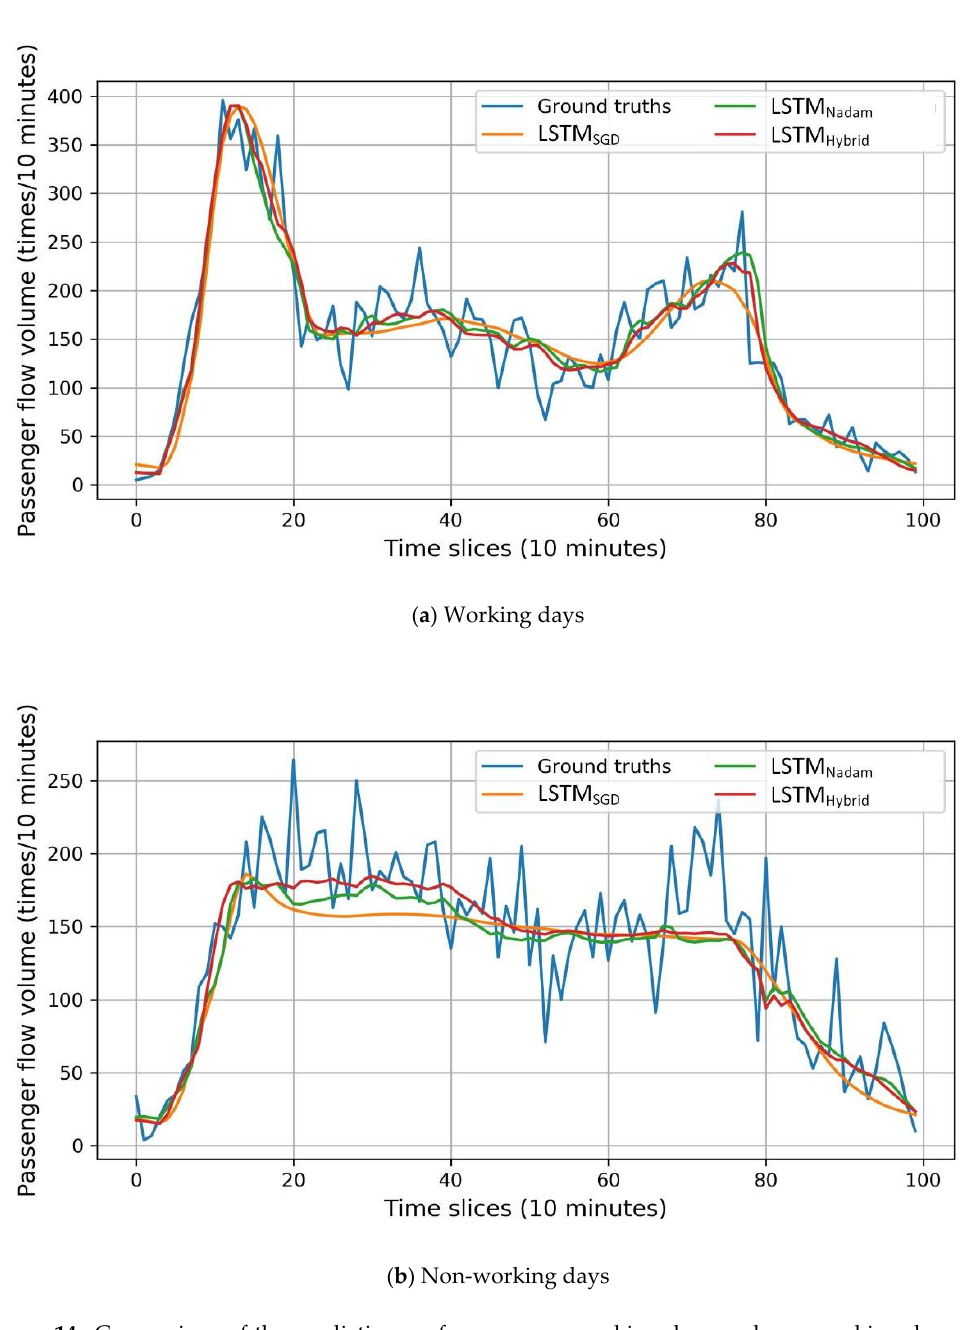
Figure 14. Comparison of the prediction performance on working days and non-working days at Licun Park.